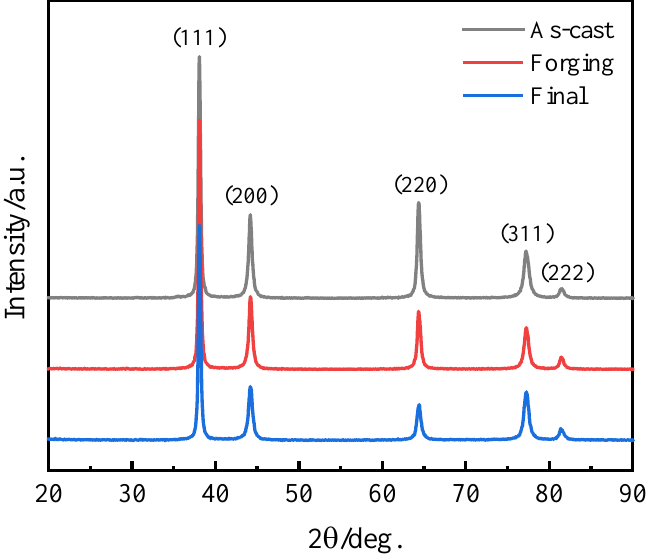
Figure 2. XRD patterns of the ITO/AgIn/ITO films at different sputtering temperatures.